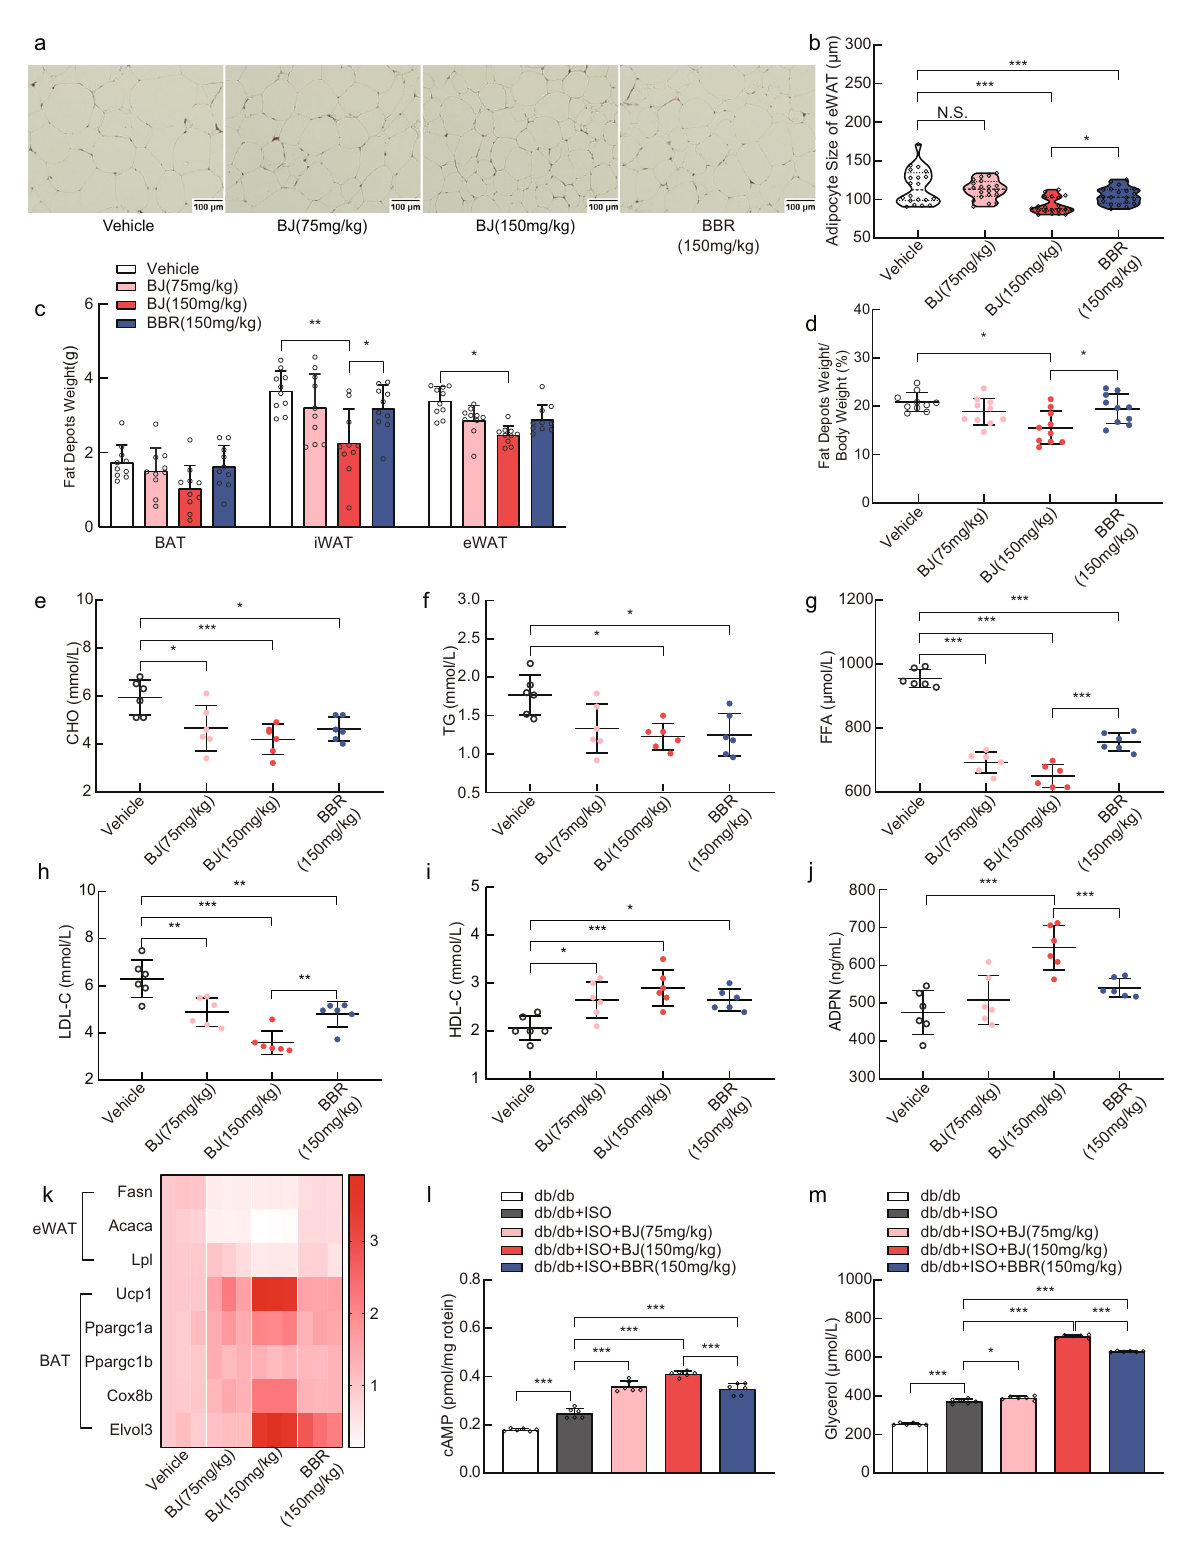
Fig. 4 BJ regulates lipid metabolism in db/db mice. a , b Representative HE staining images of epididymal adipose tissue (scale bar = 100 µ m) and adipocyte size quanti fi cation. c Weight of BAT, inguinal white adipose tissue (iWAT) and eWAT in different groups of db/db mice ( n = 10 per group) ( d ) Percentage of fat depots weight to the body weight ( n = 10 per group). e – j Serum levels of CHO, TG, FFA, LDL-C, HDL-C and ADPN in the fasted state ( n = 6 per group). k The heat map shows the expression levels of lipid-metabolism-related genes and thermogenic gene. l – m Measurement of cAMP levels and Glycerol release in eWAT of db/db mice ( n = 6 per group). Data are expressed as mean ± SD. NS not signi fi cant, * P < 0.05, ** P < 0.01, *** P <